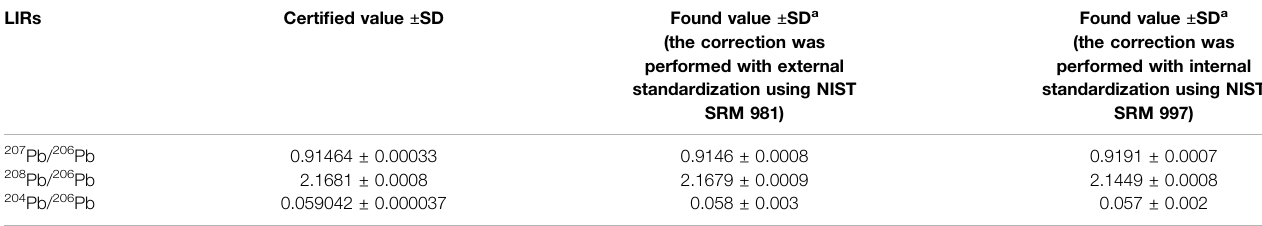
TABLE 1 | Validation of proposed method. Comparison of certi fi ed values of NIST SRM 981 with obtained LIRs by ICP-QMS using different correction protocols on mass- bias effect ( Đ ur đ i ć et al., 2020).